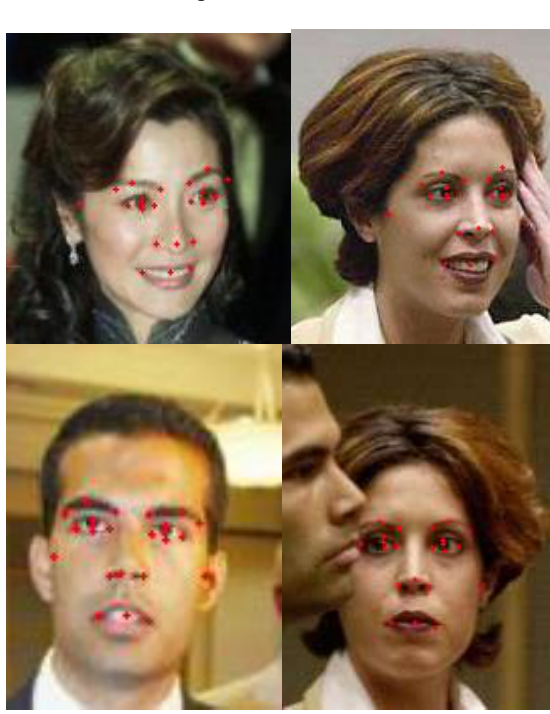
Figure 6. Detection results.